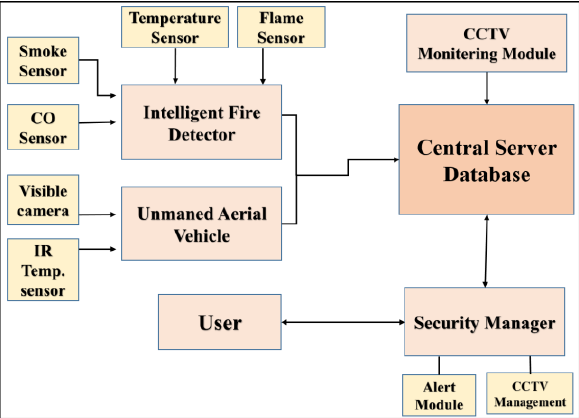
Figure 2. CSD connected wirelessly with detectors IFD, CCTV, UAV and SM in IFAS